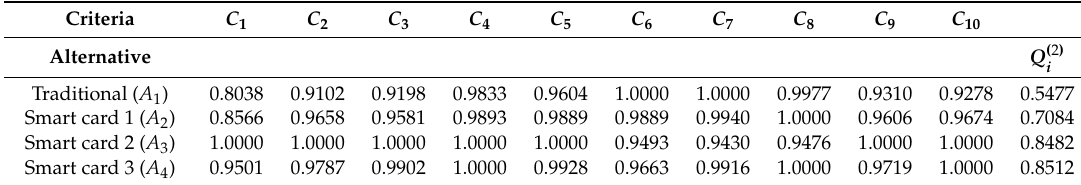
Table 7. Total relative importance values of alternatives by WPM